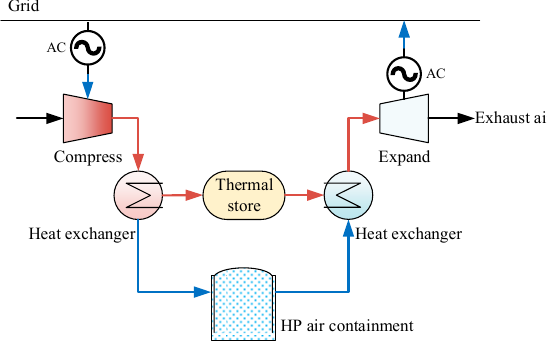
Figure 2. Schematics of the adiabatic compressed air energy storage (CAES) system.